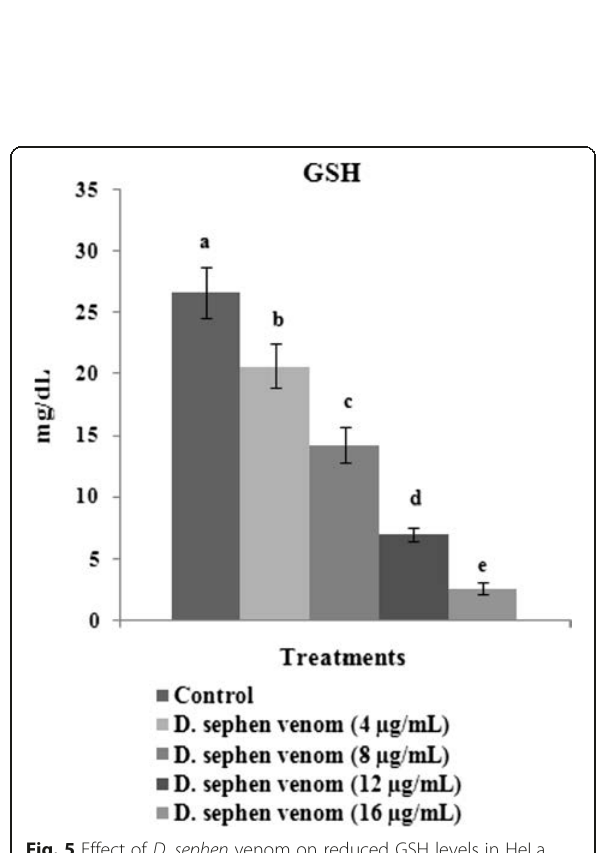
Fig. 5 Effect of D. sephen venom on reduced GSH levels in HeLa cells. Treated cells were incubated for 24 h at 37 °C and then reduced GSH levels were measured in cell lysate. Values were given as mean ± SD of six experiments in each group. Values not sharing the same letter differ significantly ( p < 0.05) from control